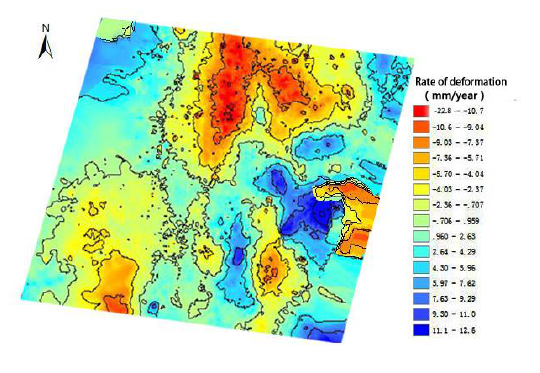
Figure 5 The subsidence rate of Envisat ASAR